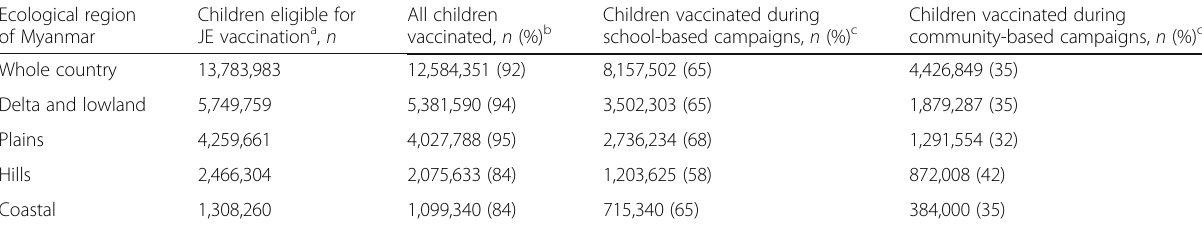
Children vaccinated during community-based campaigns, n (%) c